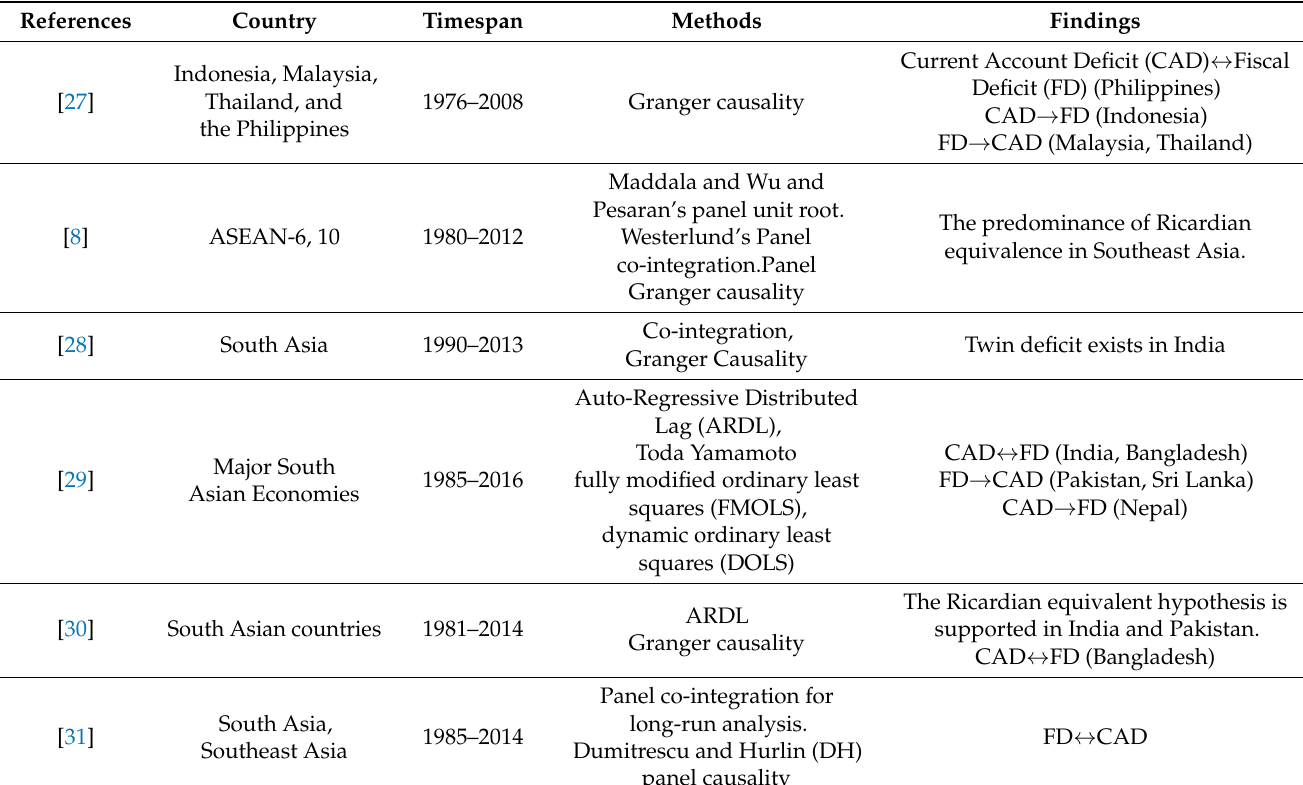
Table 2. Summary of related